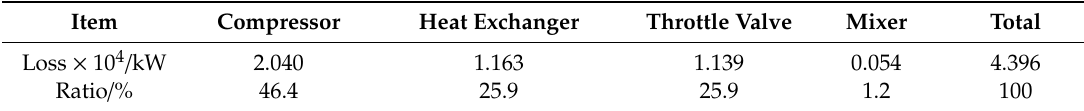
Table 4. Exergy loss of each equipment in